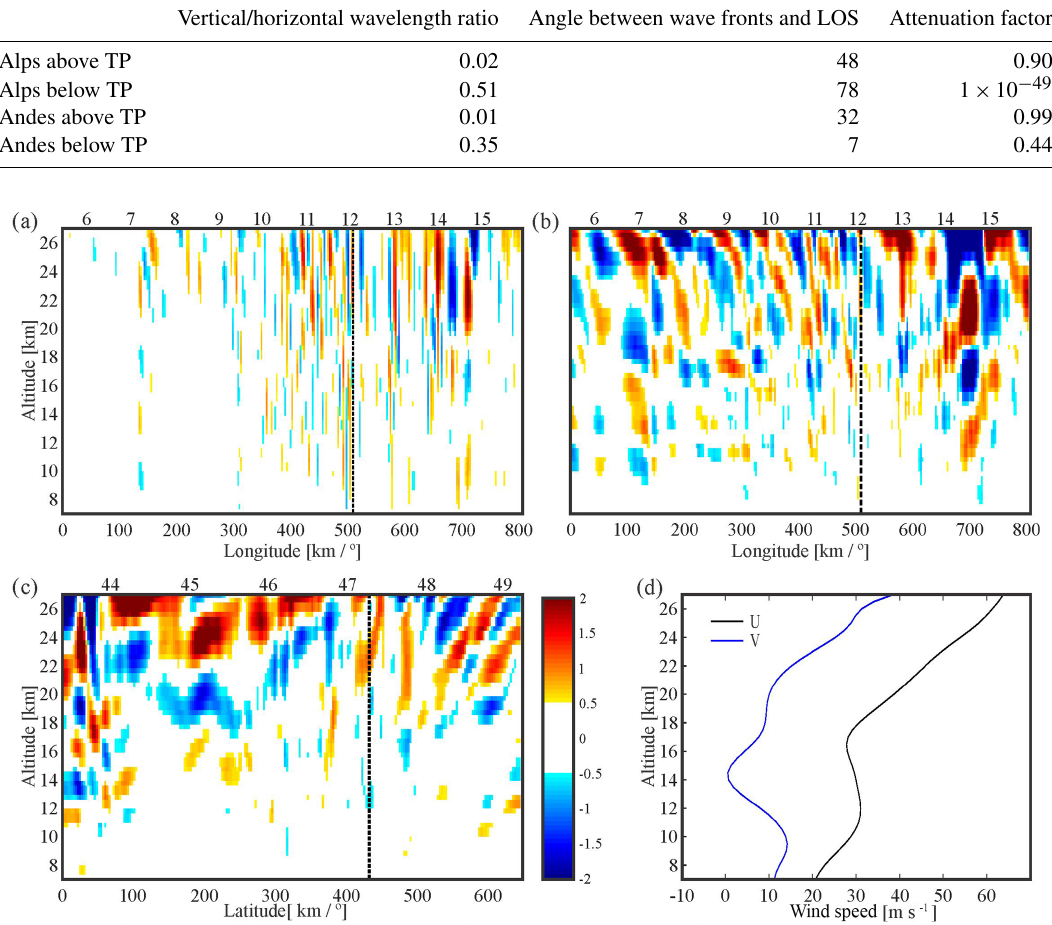
Figure 5. Simulated high-resolution GW structures in the Alps region, showing (a) δw and (b–c) δT signatures as a function of longitude and latitude, respectively. Non-stationary (stationary) GWs with longer (shorter) horizontal wavelength are more clearly seen in δT/ δw . The dotted line indicates the position of the TP. (d) Zonal and meridional mean